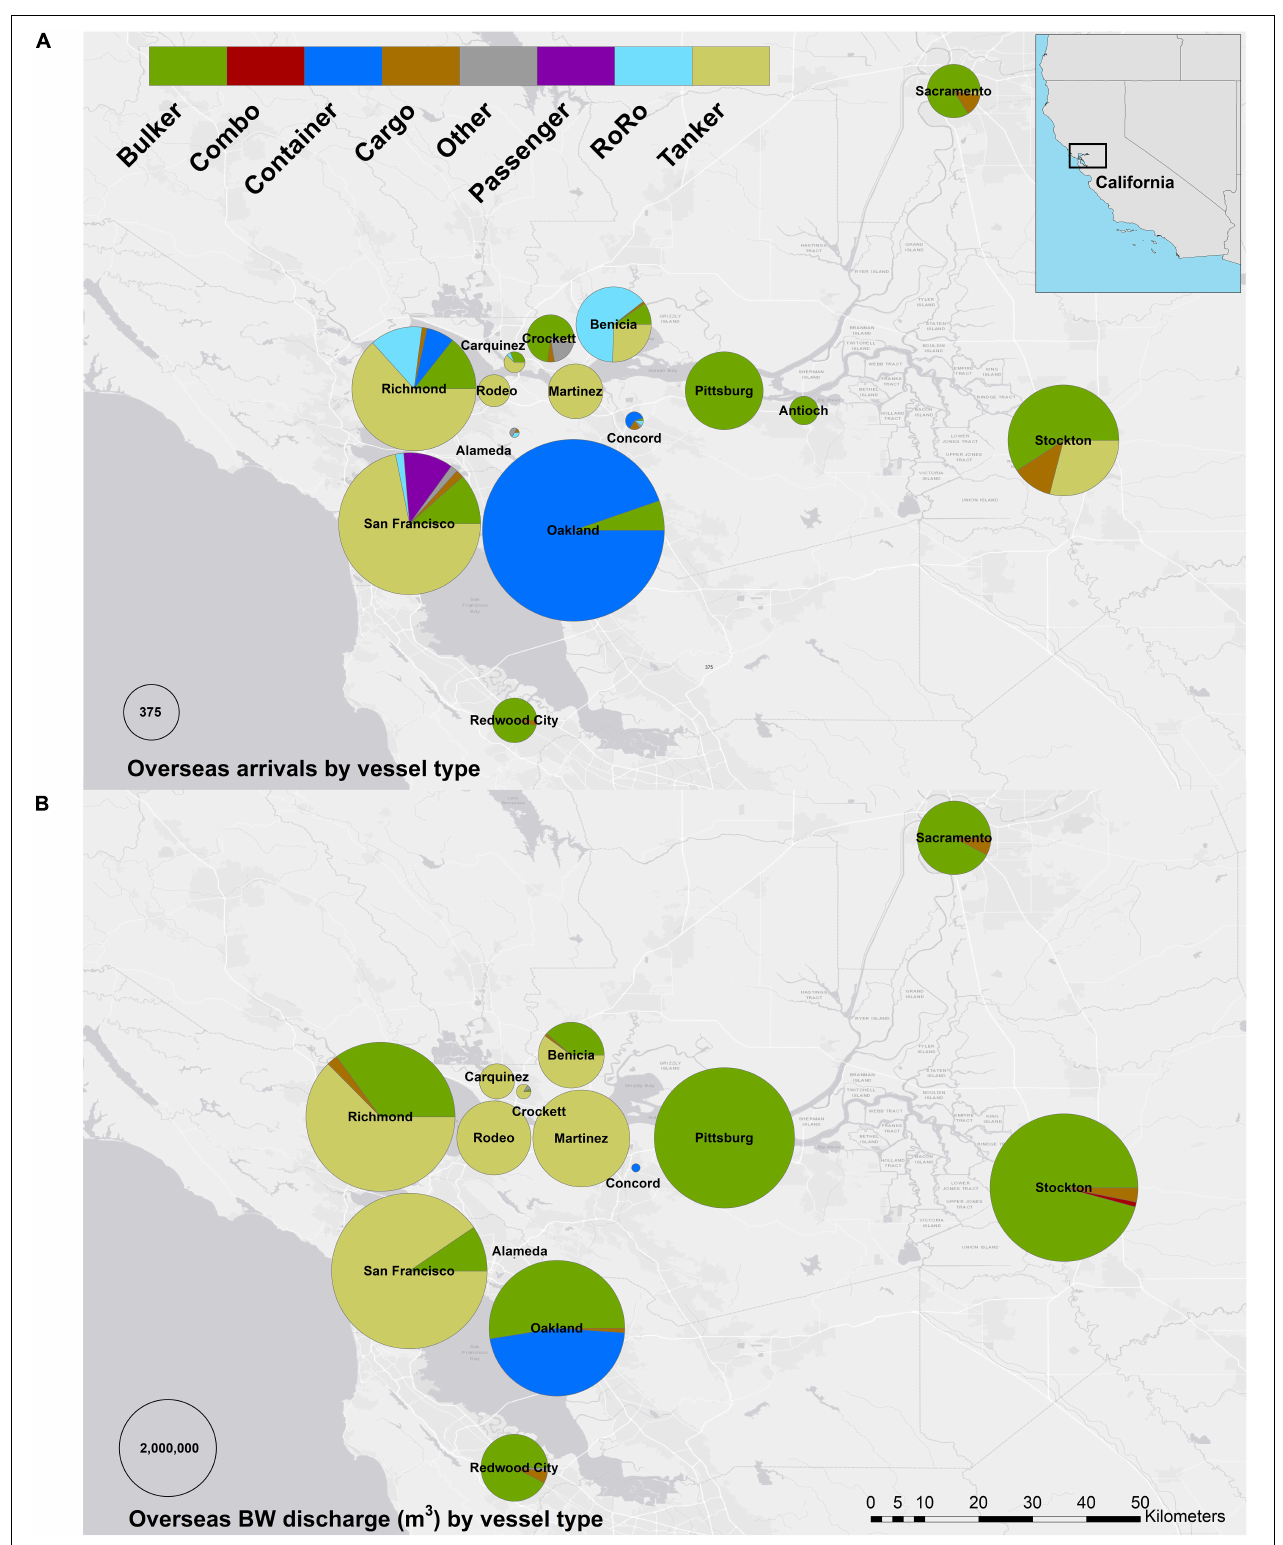
FIGURE 4 | The relative contribution of vessel type to (A) total overseas vessel arrivals and (B) overseas ballast water discharge to ports within San Francisco Bay from 2006 through 2014. Scale is shown in bottom left of each figure for arrivals (A) and discharge (B) .